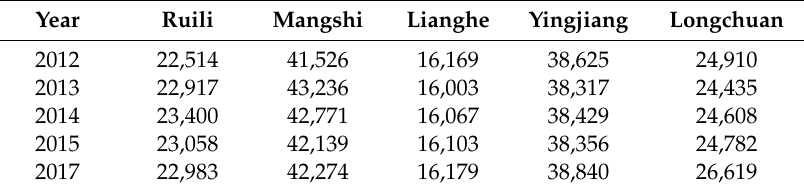
Table 5. Total rural area DN values for the DH Prefecture from 2012 to